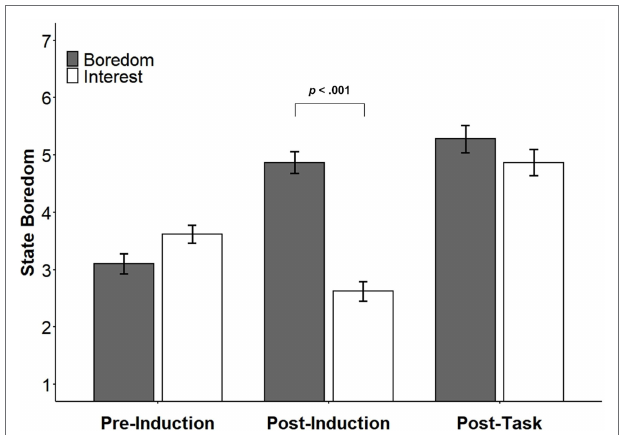
FIGURE 3 | Mean (±SE) ratings of boredom before and after the mood inductions as well as following completion of the 2-back task among participants exposed to the boredom and interest mood inductions. Significant differences between conditions are indicated with brackets above the